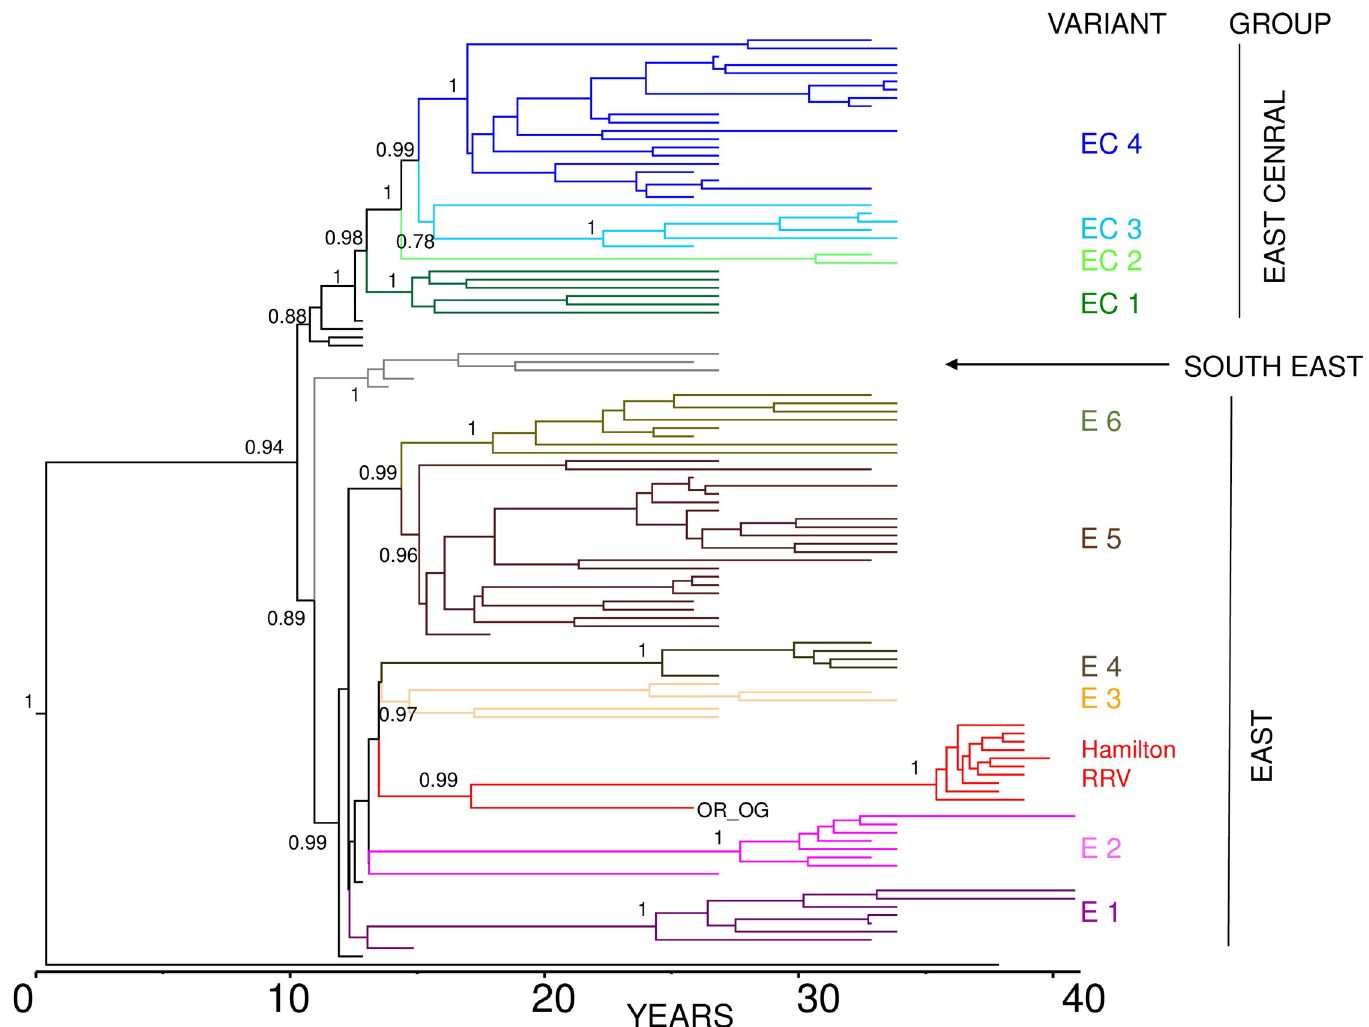
Fig 3. Phylogenetic comparison of representative Hamilton RRV samples with isolates from counties in eastern New York. This MCC tree was generated by coalescent analysis performed on 112 samples, including 10 representatives of the Hamilton outbreak, and a member of the NY W group included as an outgroup. Color- coded variants are identified to the right of the tree; early samples from the 1990s which do not cluster with any confidence to a specific clade remain in black. The sample clustering as an outlier to the Hamilton RRV group (NY.2003.7427) is represented as OR_OG. Posterior values for many major branch points are shown to the left of the node. The scale at bottom indicates the timeframe in